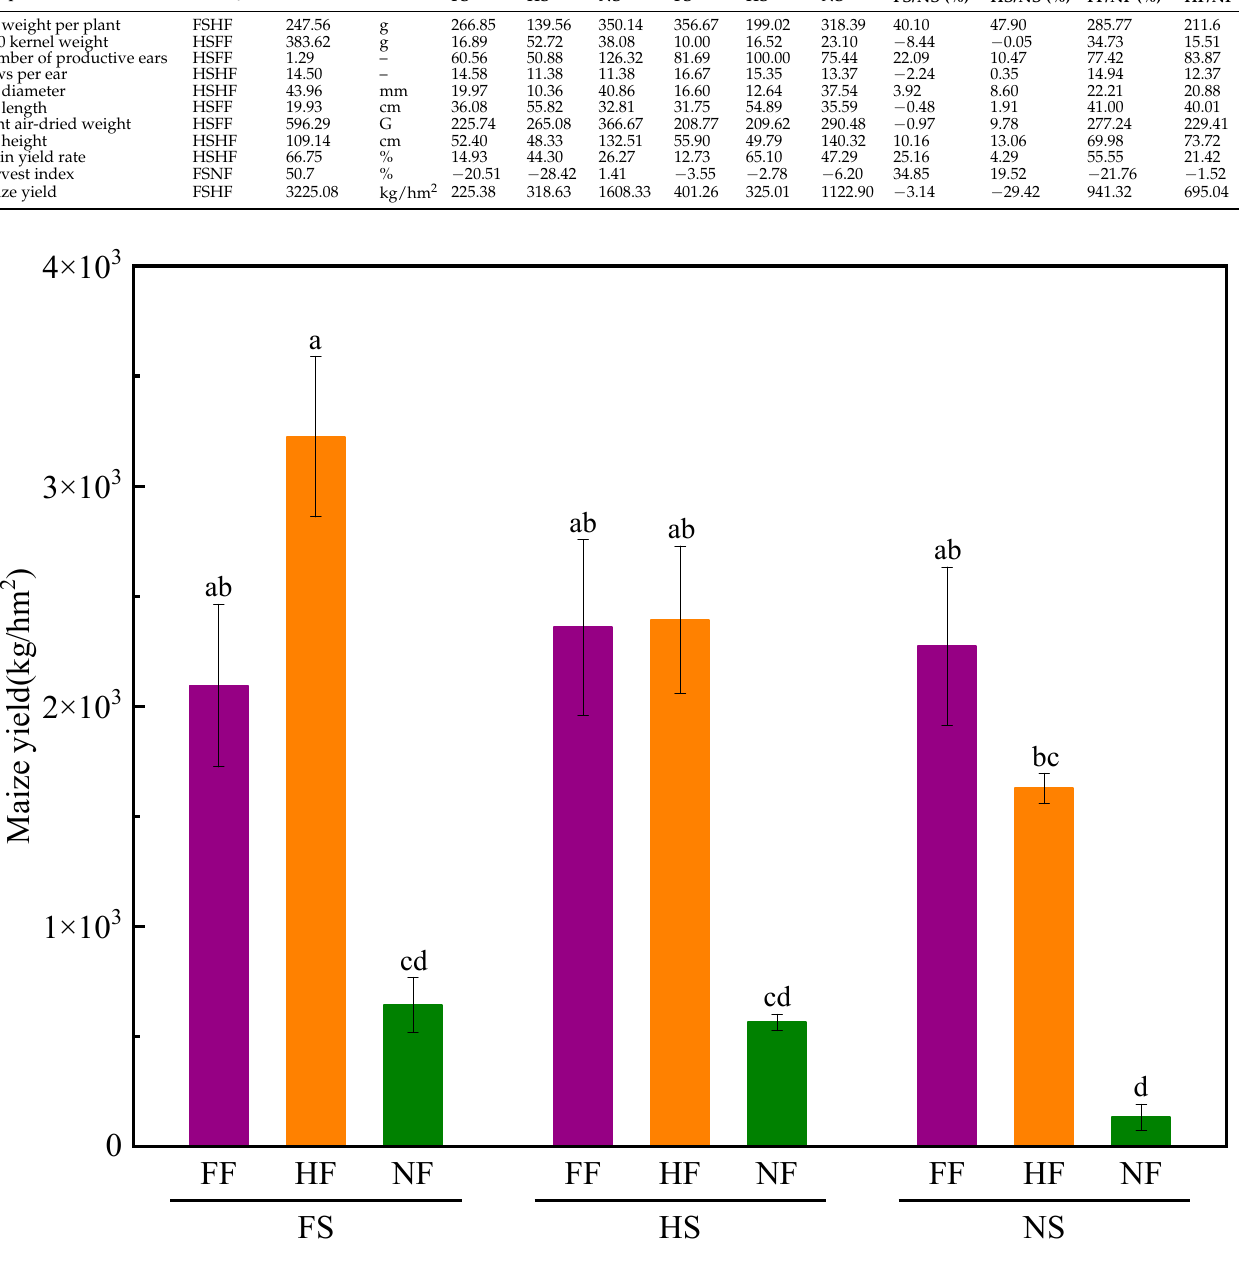
Table 2. Reanalysis results of different experimental treatments of maize yield component factor and yield. FF/NF (%) HF/NF (%) Multiple Comparison Results Treatment Maximum Yield Acronyms Value Unit Component Factor